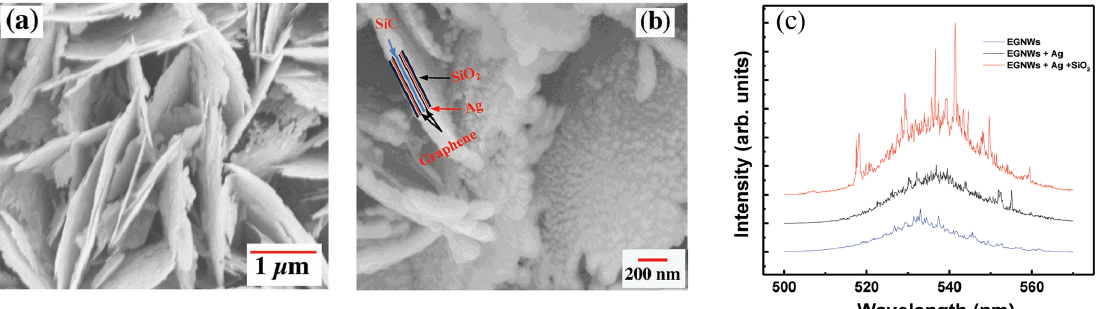
Figure 6. ( a ) Top FE-SEM image showing the morphology of the epitaxial graphene nanowalls (EGNWs) grown on Si (111) using MPECVD. ( b ) Cross-sectional view of one nanowall after coating with the Ag/SiO 2 layers. The lines are guides to the eye and do not resemble in exact scale the constituent layers. ( c ) Emission spectra of EGNWs/PNC, EGNWs/Ag/PNC, and EGNWs/Ag/SiO2/PNC at a constant pump density of 14.19 nJcm − 2 . Adapted with permission from [46]. John Wiley and Sons,